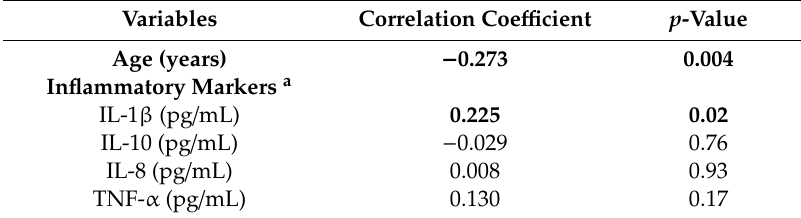
Table3. Correlationsbetweenlog-cotinineandlog-inflammatorymarkervaluesofhospitalizedchildren.